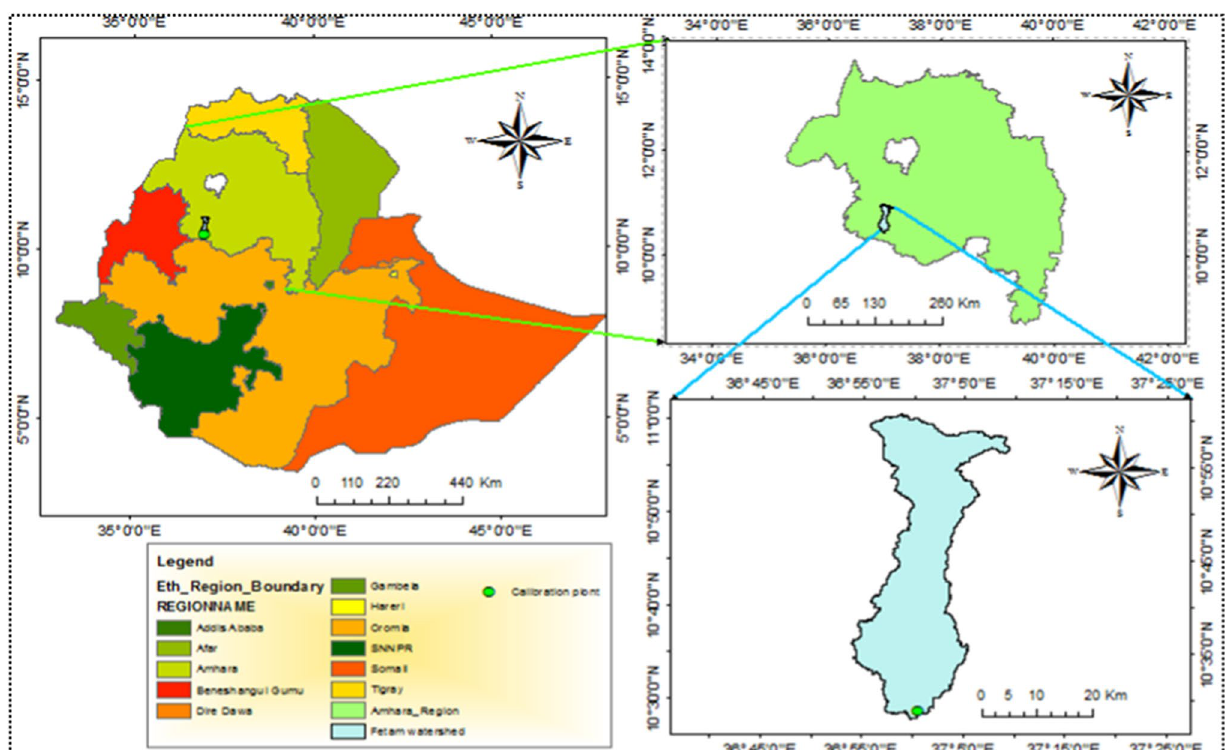
Fig. 1 Location of Fetam catchment (Source: Ministry of Water